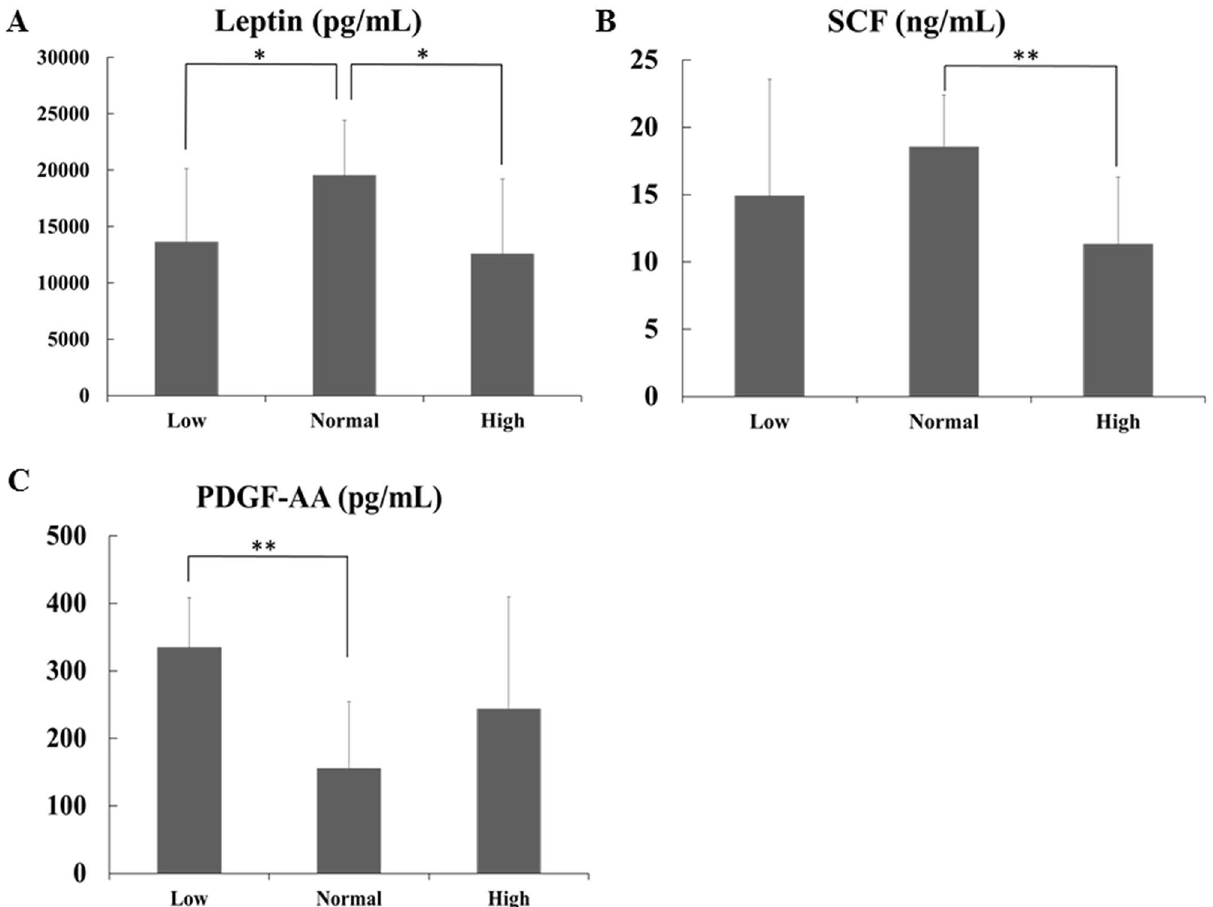
Figure 3. Significant differences in cytokine levels of follicular fluid according to AMH level. Cytokine concentrations (pg/mL) in follicular fluid collected during oocyte retrieval, including ( A ) leptin, ( B ) stem cell factor (SCF), and ( C ) platelet derived growth factor AA (PDGF-AA). Data are presented as the mean ± SD. Statistical analyses were performed using the Kruskal–Wallis test. *p < 0.05; **p < 0.01. Groups: low, low ovarian reserve (AMH < 2 ng/mL); normal, normal ovarian reserve (AMH 2–5 ng/mL); high, high ovarian reserve (AMH > 5